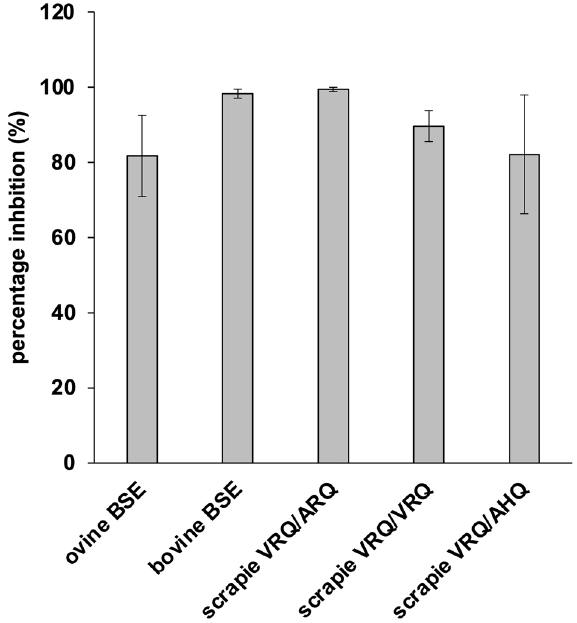
Figure 4. Inhibition of the replication of ruminant prion strains/isolates with rRRQ. Ovine BSE genotype ARQ/ARQ was amplified in 2 rounds using alternating ARQ/ARQ and AHQ/AHQ substrates. Bovine BSE was amplified in bovine brain substrate, and ovine scrapie isolates with VRQ/ARQ, VRQ/VRQ and VRQ/AHQ genotypes amplified in ovine VRQ/VRQ brain substrate; all amplified over 5 rounds of amplification. rRRQ was added into each round of PMCA at 50 nM. PMCA amplification in the absence of any rPrP was carried out as a no inhibition control. Dot blot images were analysed by densitometry and the PrP Sc signal above background (samples with no PMCA amplification carried out in the final round of sPMCA) were expressed as a percentage of the no inhibition control. Three replicate PMCA reactions were carried out and each analysed in duplicate by dot blot, SD for the average signal for each of the triplicates are shown. rRRQ significantly inhibited each of the amplification reactions (+ /− inhibitor signals compared in a one-way ANOVA with Šidák’s multiple comparison test).